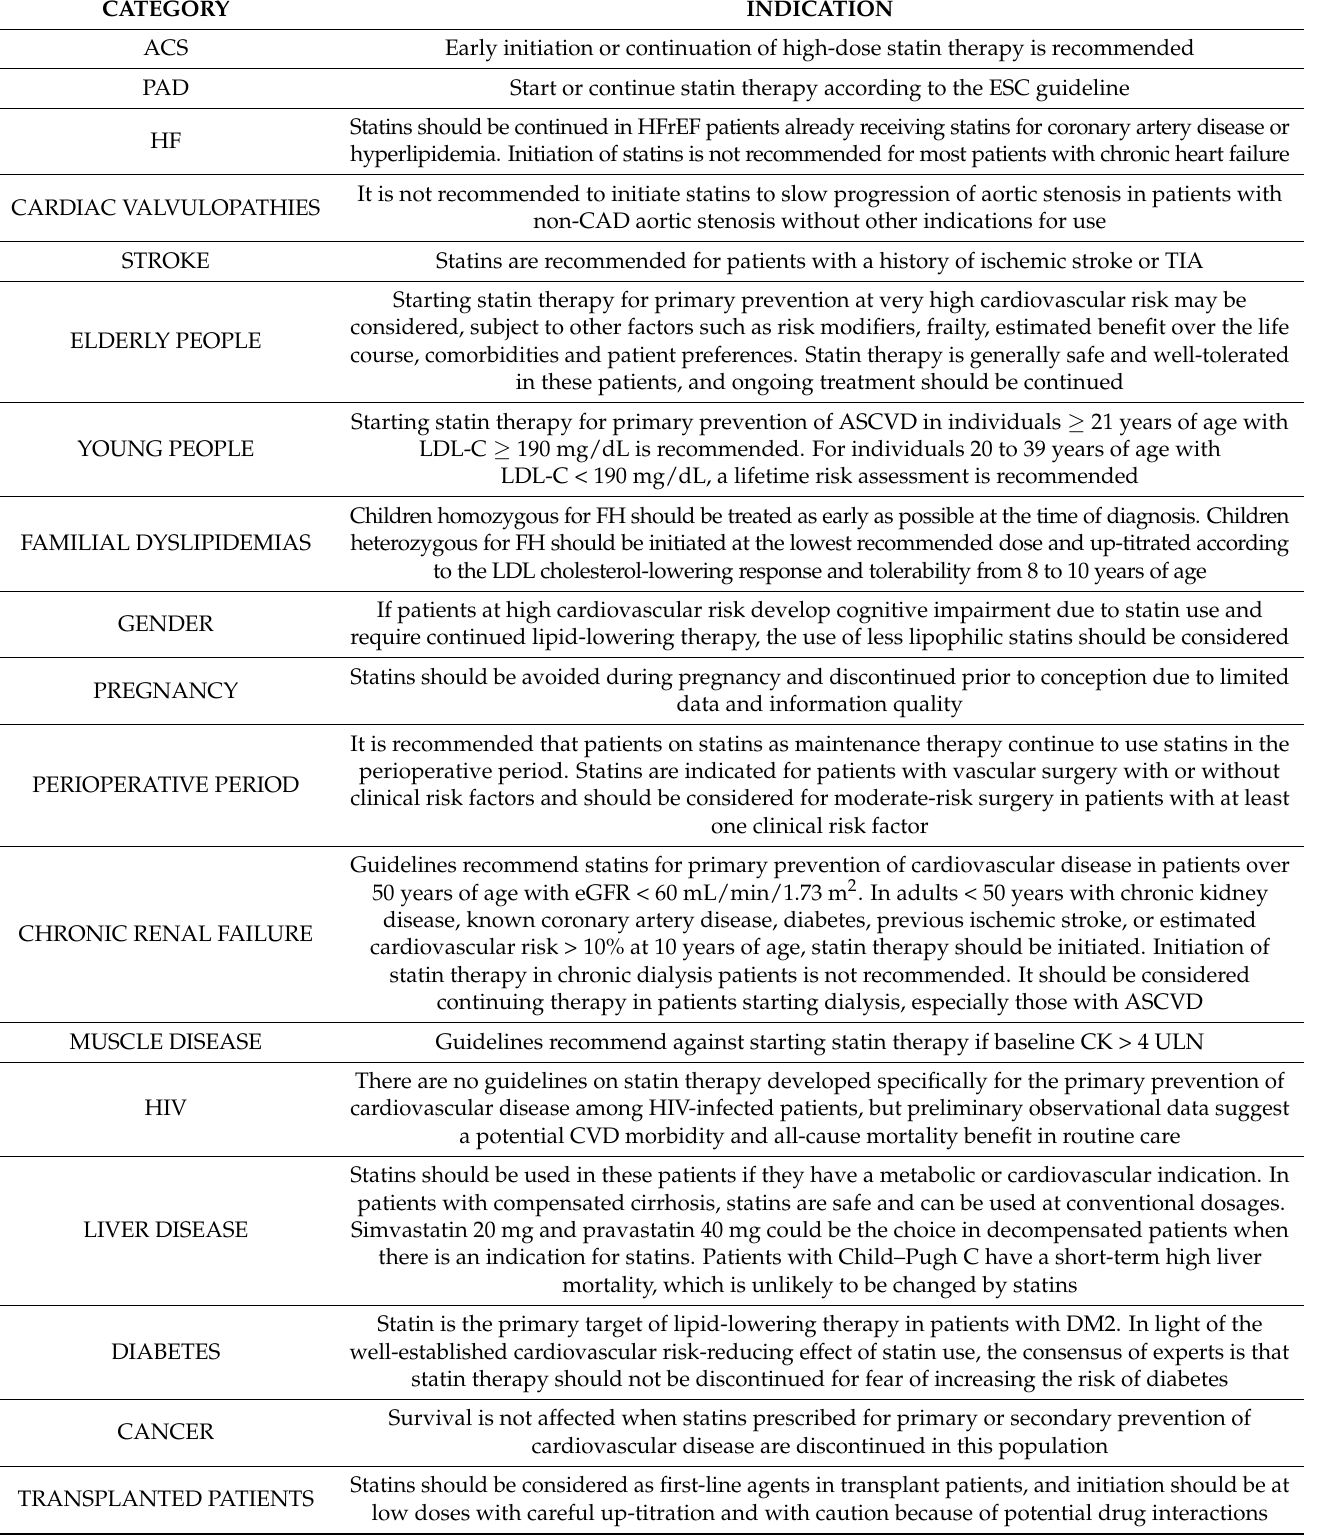
Table 2. Indications for initiation or continuation of statin therapy in different categories of high cardiovascular risk